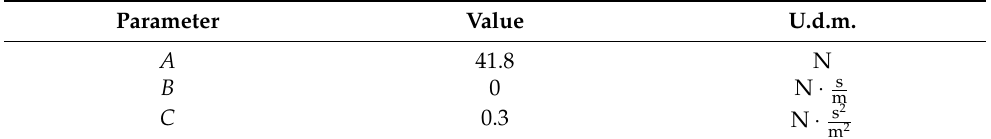
Figure 15. Road load power terms acting on vehicle body as a velocity-dependent function. Table 9. Coastdown coefficients values for longitudinal dynamic vehicle modeling. A , B and C are the coefficients for describing the resistive forces depending on the vehicle